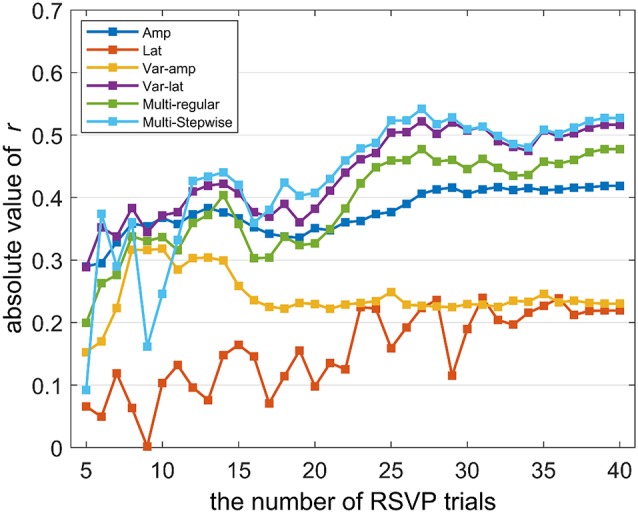
The correlation changes over the number of trials. This represents the way correlations change when the number of RSVP trials used to calculate EEG features varies. The X-axis represents the number of trials (1st to Nth RSVP trial), and the Y-axis represents the Pearson’s correlation coefficient’s absolute value.